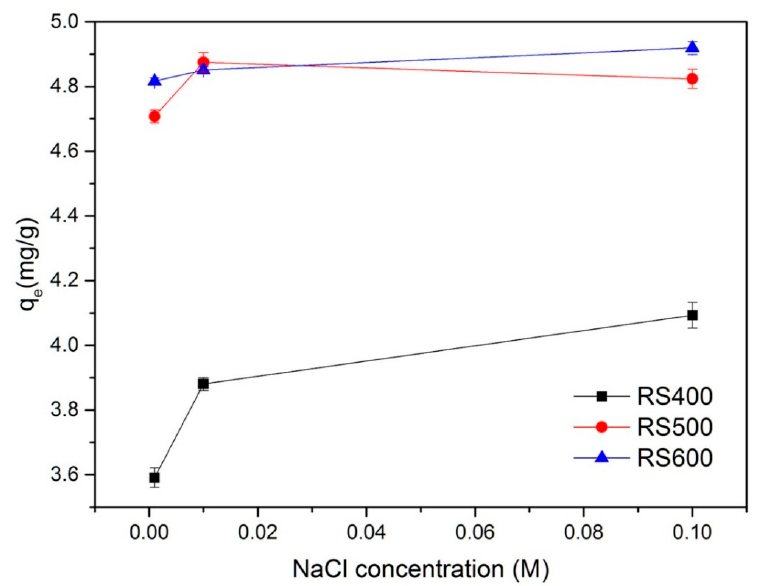
Figure 5. Effect of the ionic strength (initial concentration = 1 mg L − 1 ; biochar dose = 0.01 g; temperature = 301 K).